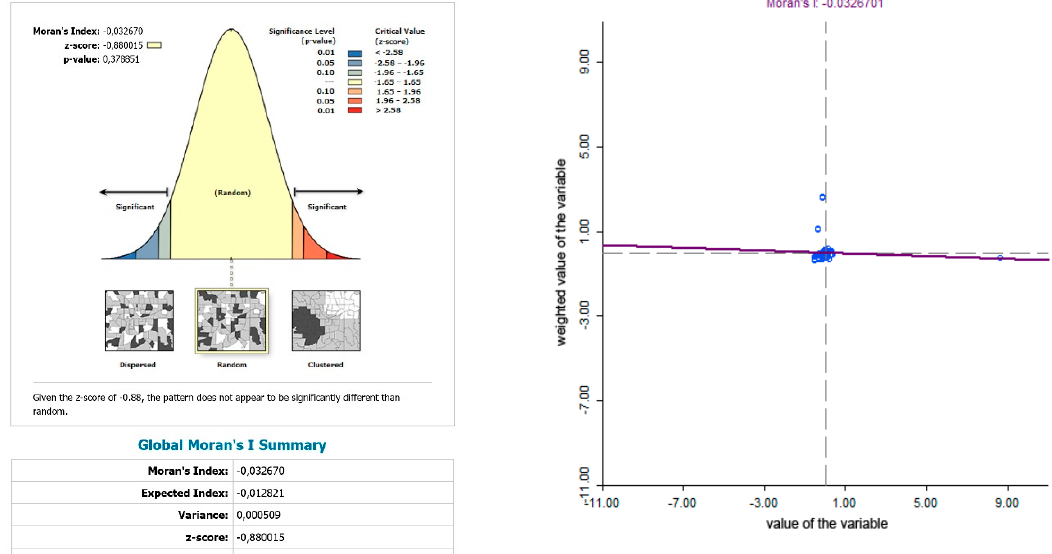
Figure 4. Reginalization of Slovakia based on the LISA analysis for standardized death rate of breast cancer per 1000 inhabitants of European Standard Population, 2007–2012. Source: Statistical Office of the Slovak Republic, 2019.